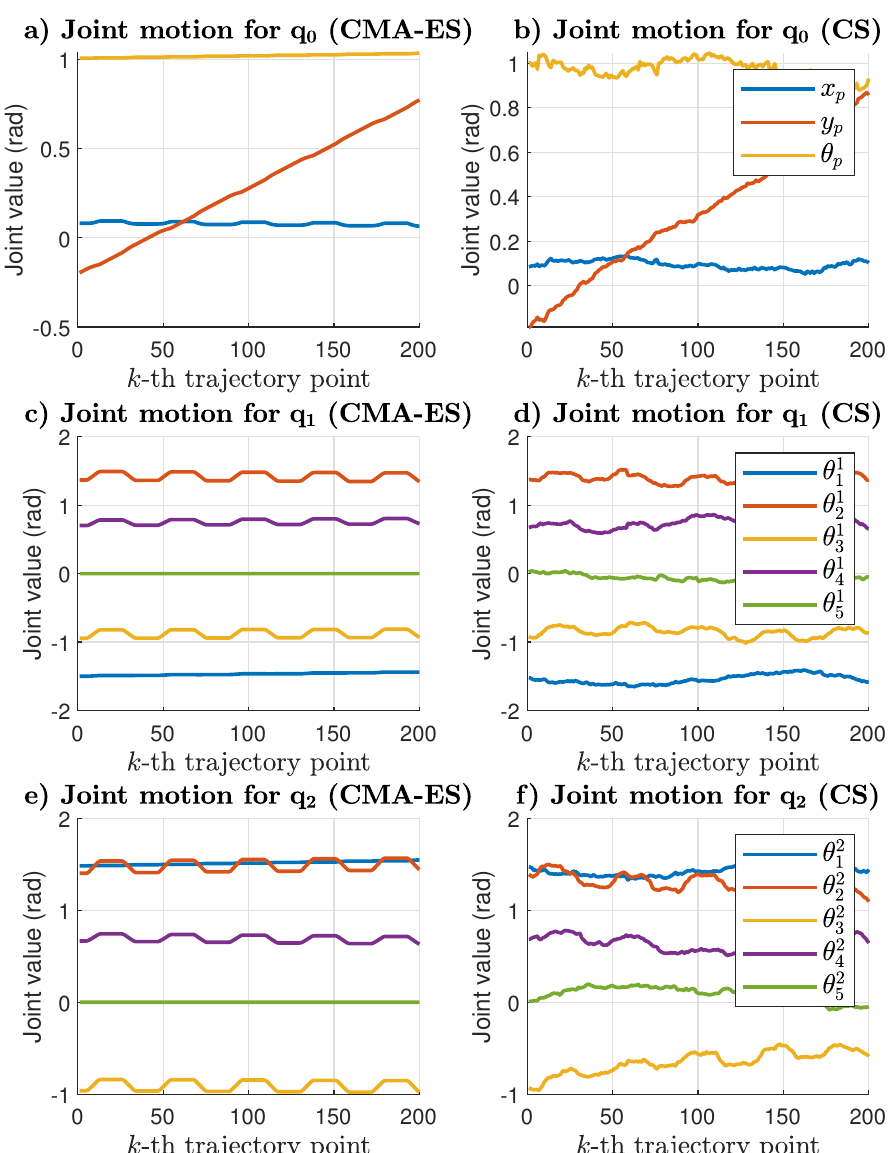
Figure 10. Joint motion comparative results for coordinated trapezoidal tracking. The compared algorithms are CMA-ES and